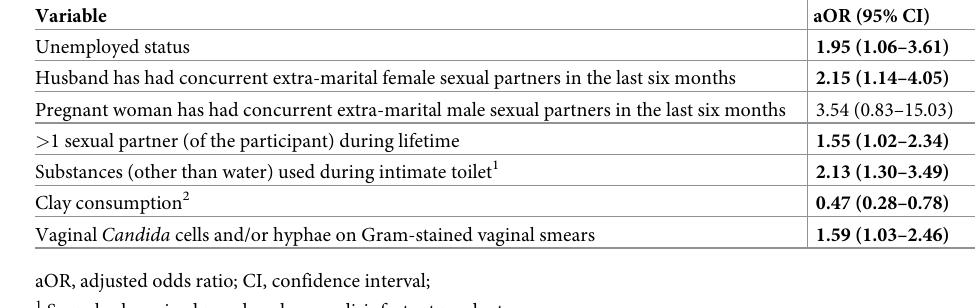
Table 3. Multivariable model of risk factors associated with bacterial vaginosis in pregnancy. Variable